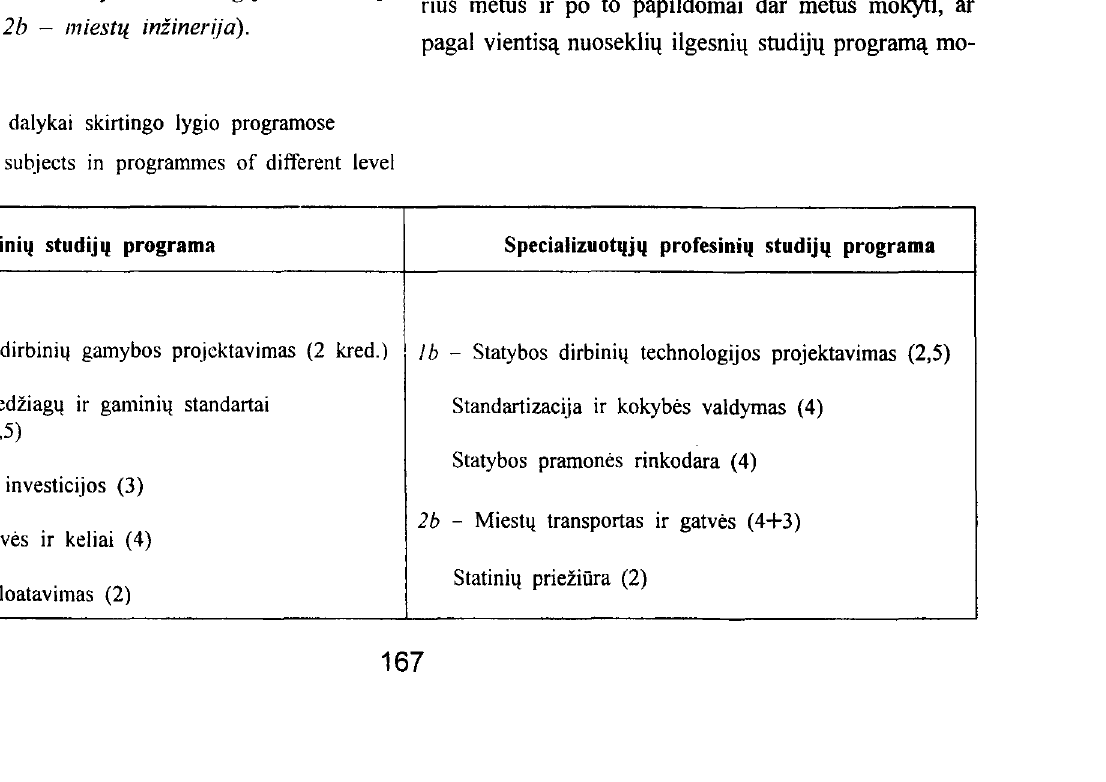
Table 2. Similar subjects in programmes of different